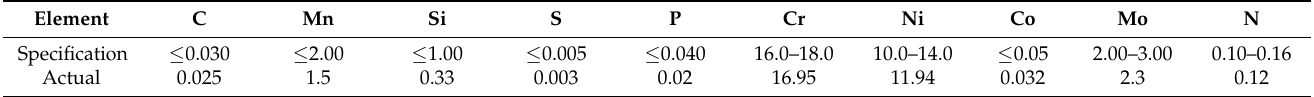
Table 4. Chemical composition of the stainless steel